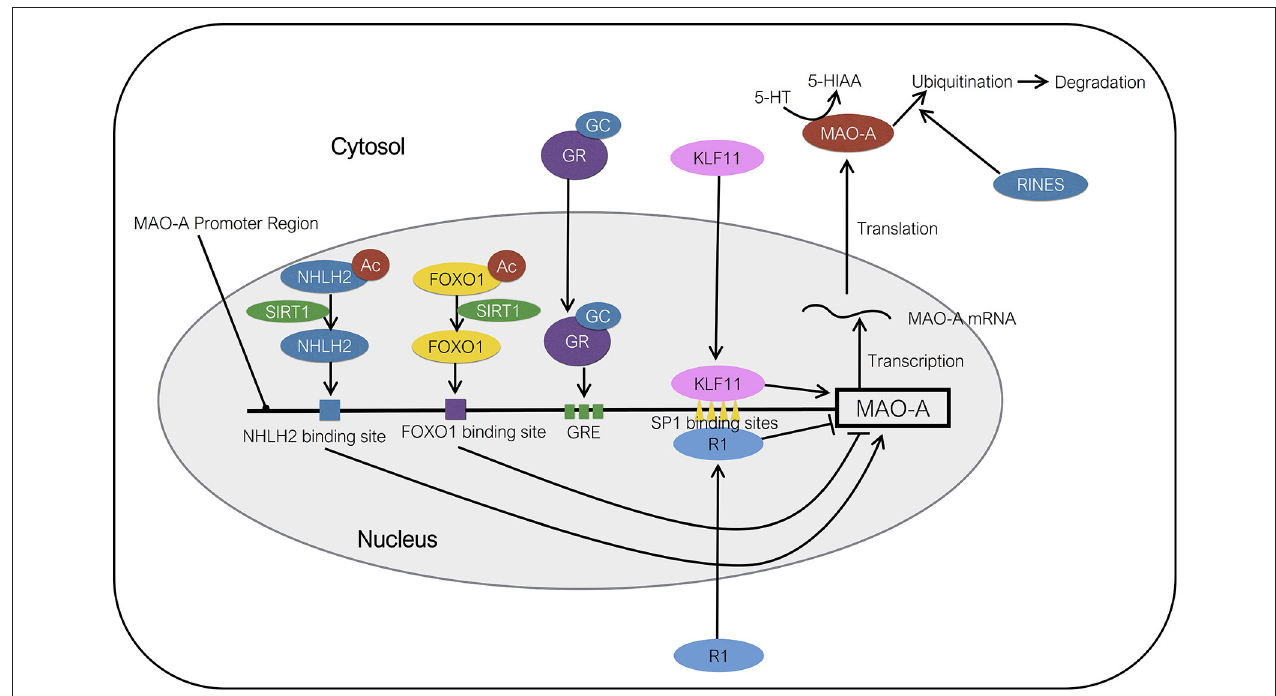
FIGURE 2 | Molecular regulation of MAO-A expression. KLF11 activates the transcription of MAO-A by binding to SP1 binding sites. NHLH2 deacetylated by SIRT1 acts as a transcriptional activator of MAO-A. FOXO1 deacetylated by SIRT1 functions as a transcriptional suppressor of MAO-A. RINES promotes the ubiquitination and degradation of MAO-A protein. R1 represses the transcription of MAO-A gene by binding to SP1 binding sites. The order of protein binding sites in the MAO-A promoter region is illustrated ambiguously. Ac, acetyl group; GC, glucocorticoids; GR, glucocorticoid receptor; GRE, GC response